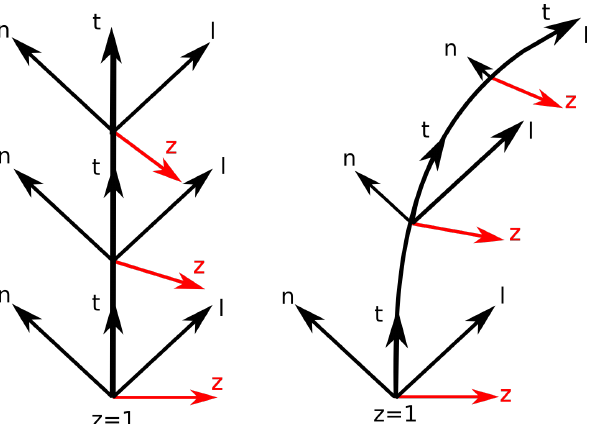
and ∂ a z behave on the right boundary t